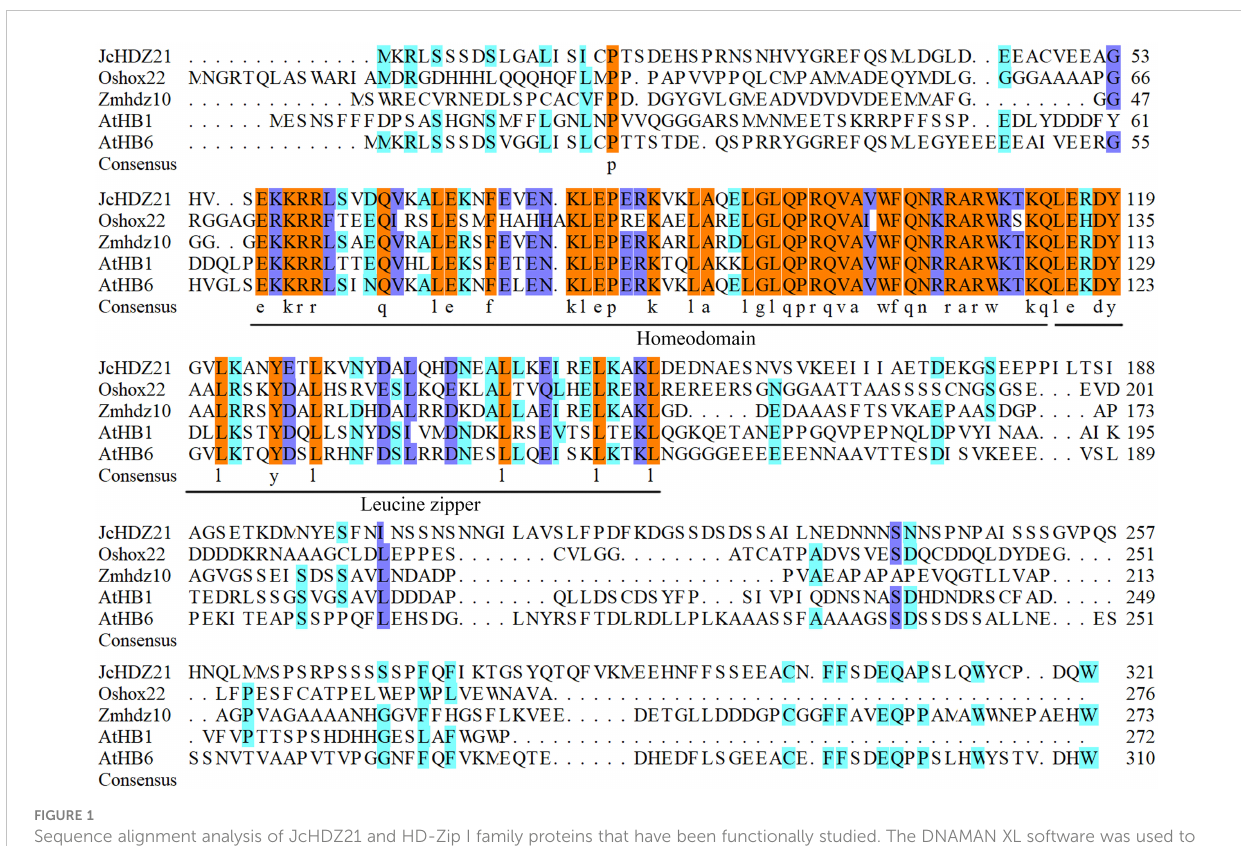
FIGURE 1 Sequence alignment analysis of JcHDZ21 and HD-Zip I family proteins that have been functionally studied. The DNAMAN XL software was used to perform the sequence alignment